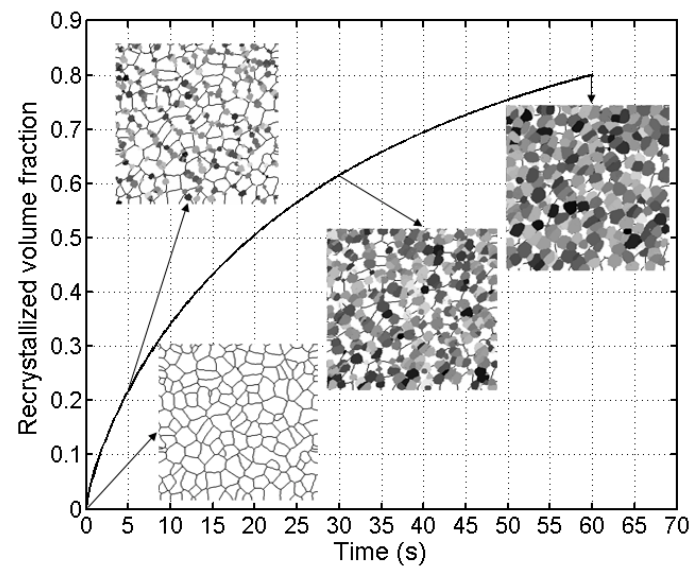
Figure 10. Changes in the recrystallized volume fraction as a function of delay time.